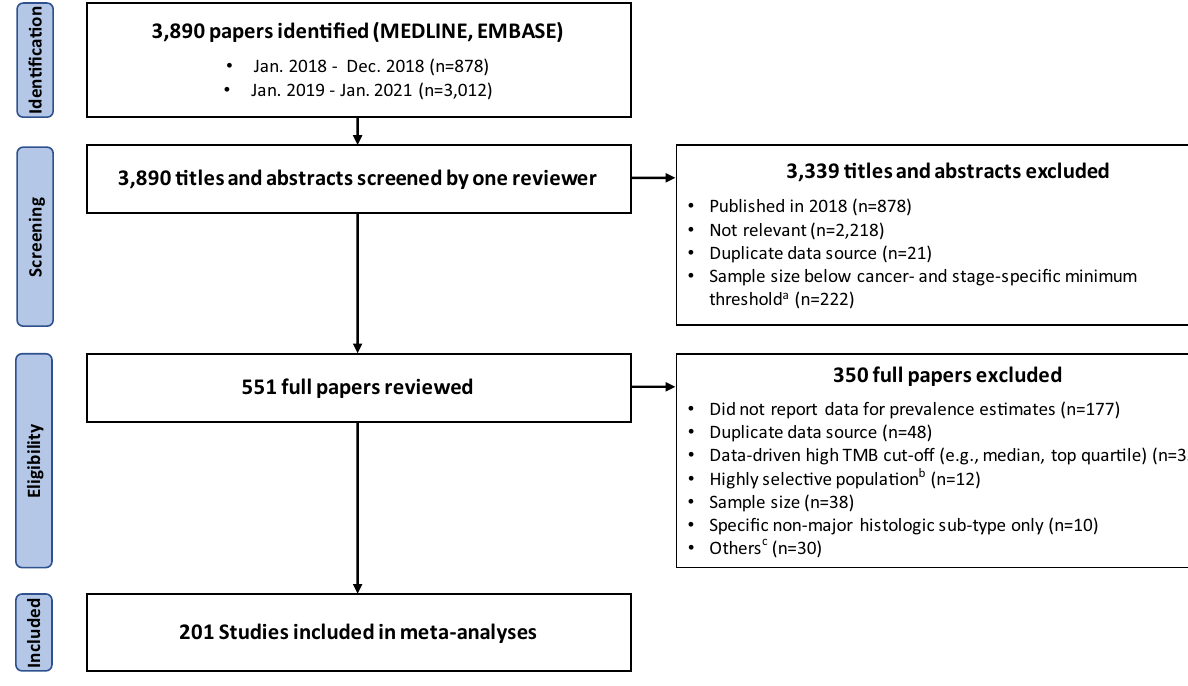
Figure 1. Scoping review process. a We determined a minimum sample size threshold for each cancer type and stage to focus on estimates from larger studies where available, while retaining 10+ studies (see Supplementary Table S6 for details). b Excluding studies focused on selected populations based on family history or inherited predisposition to cancer, rare histologic subtype(s) only, or specific molecular subtypes only. c Other reasons for exclusion are unavailability of the full-text article (n = 10), focus on validation of a new assay (n = 8), use of blood rather than tumour samples (n = 8), and < 4 mismatch repair proteins evaluated by immunohistochemistry for colorectal cancer (n =